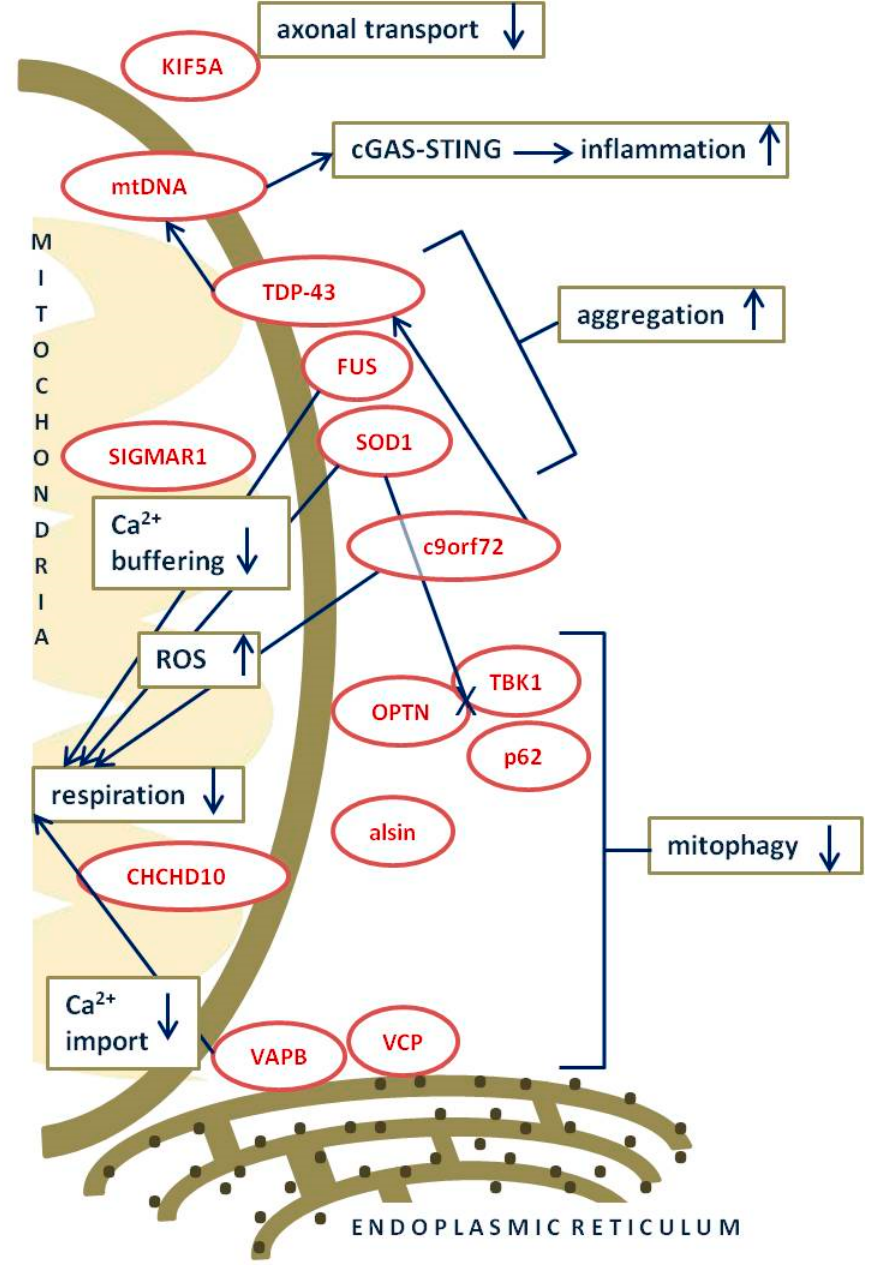
Figure 1. Schematic summary of most prominent ALS–associated mutated genes and their involve- ment in mitochondrial dysfunction. Dark blue text in squares with green ochre outline—processes affected by ALS–associated mutated genes; dark red text in oval shape with red outline—ALS– associated mutant proteins; dark blue long arrows—connecting ALS–associated mutant proteins with affected processes; up/down arrows—increased/decreased process; dark blue long line with X—impaired interaction of proteins; square black dots—ribosomes. More detailed explanation of par- ticular mechanisms is in the following text.